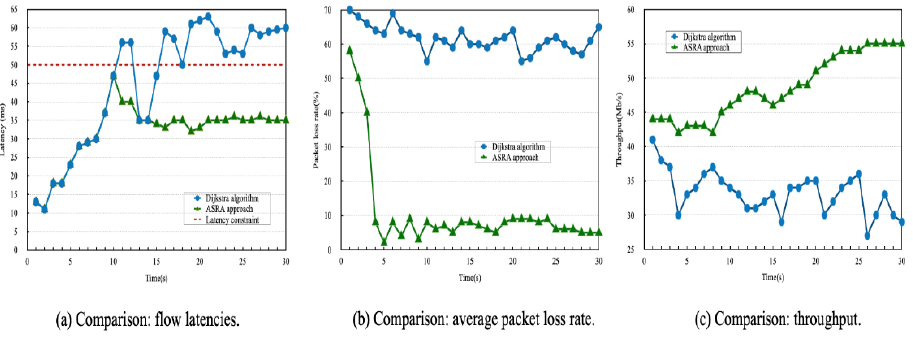
Fig. 3. Comparison